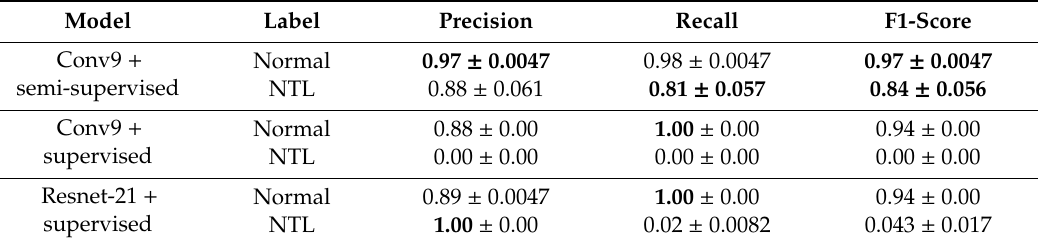
Table 4. Comparison of semi-supervised and supervised learning methods.